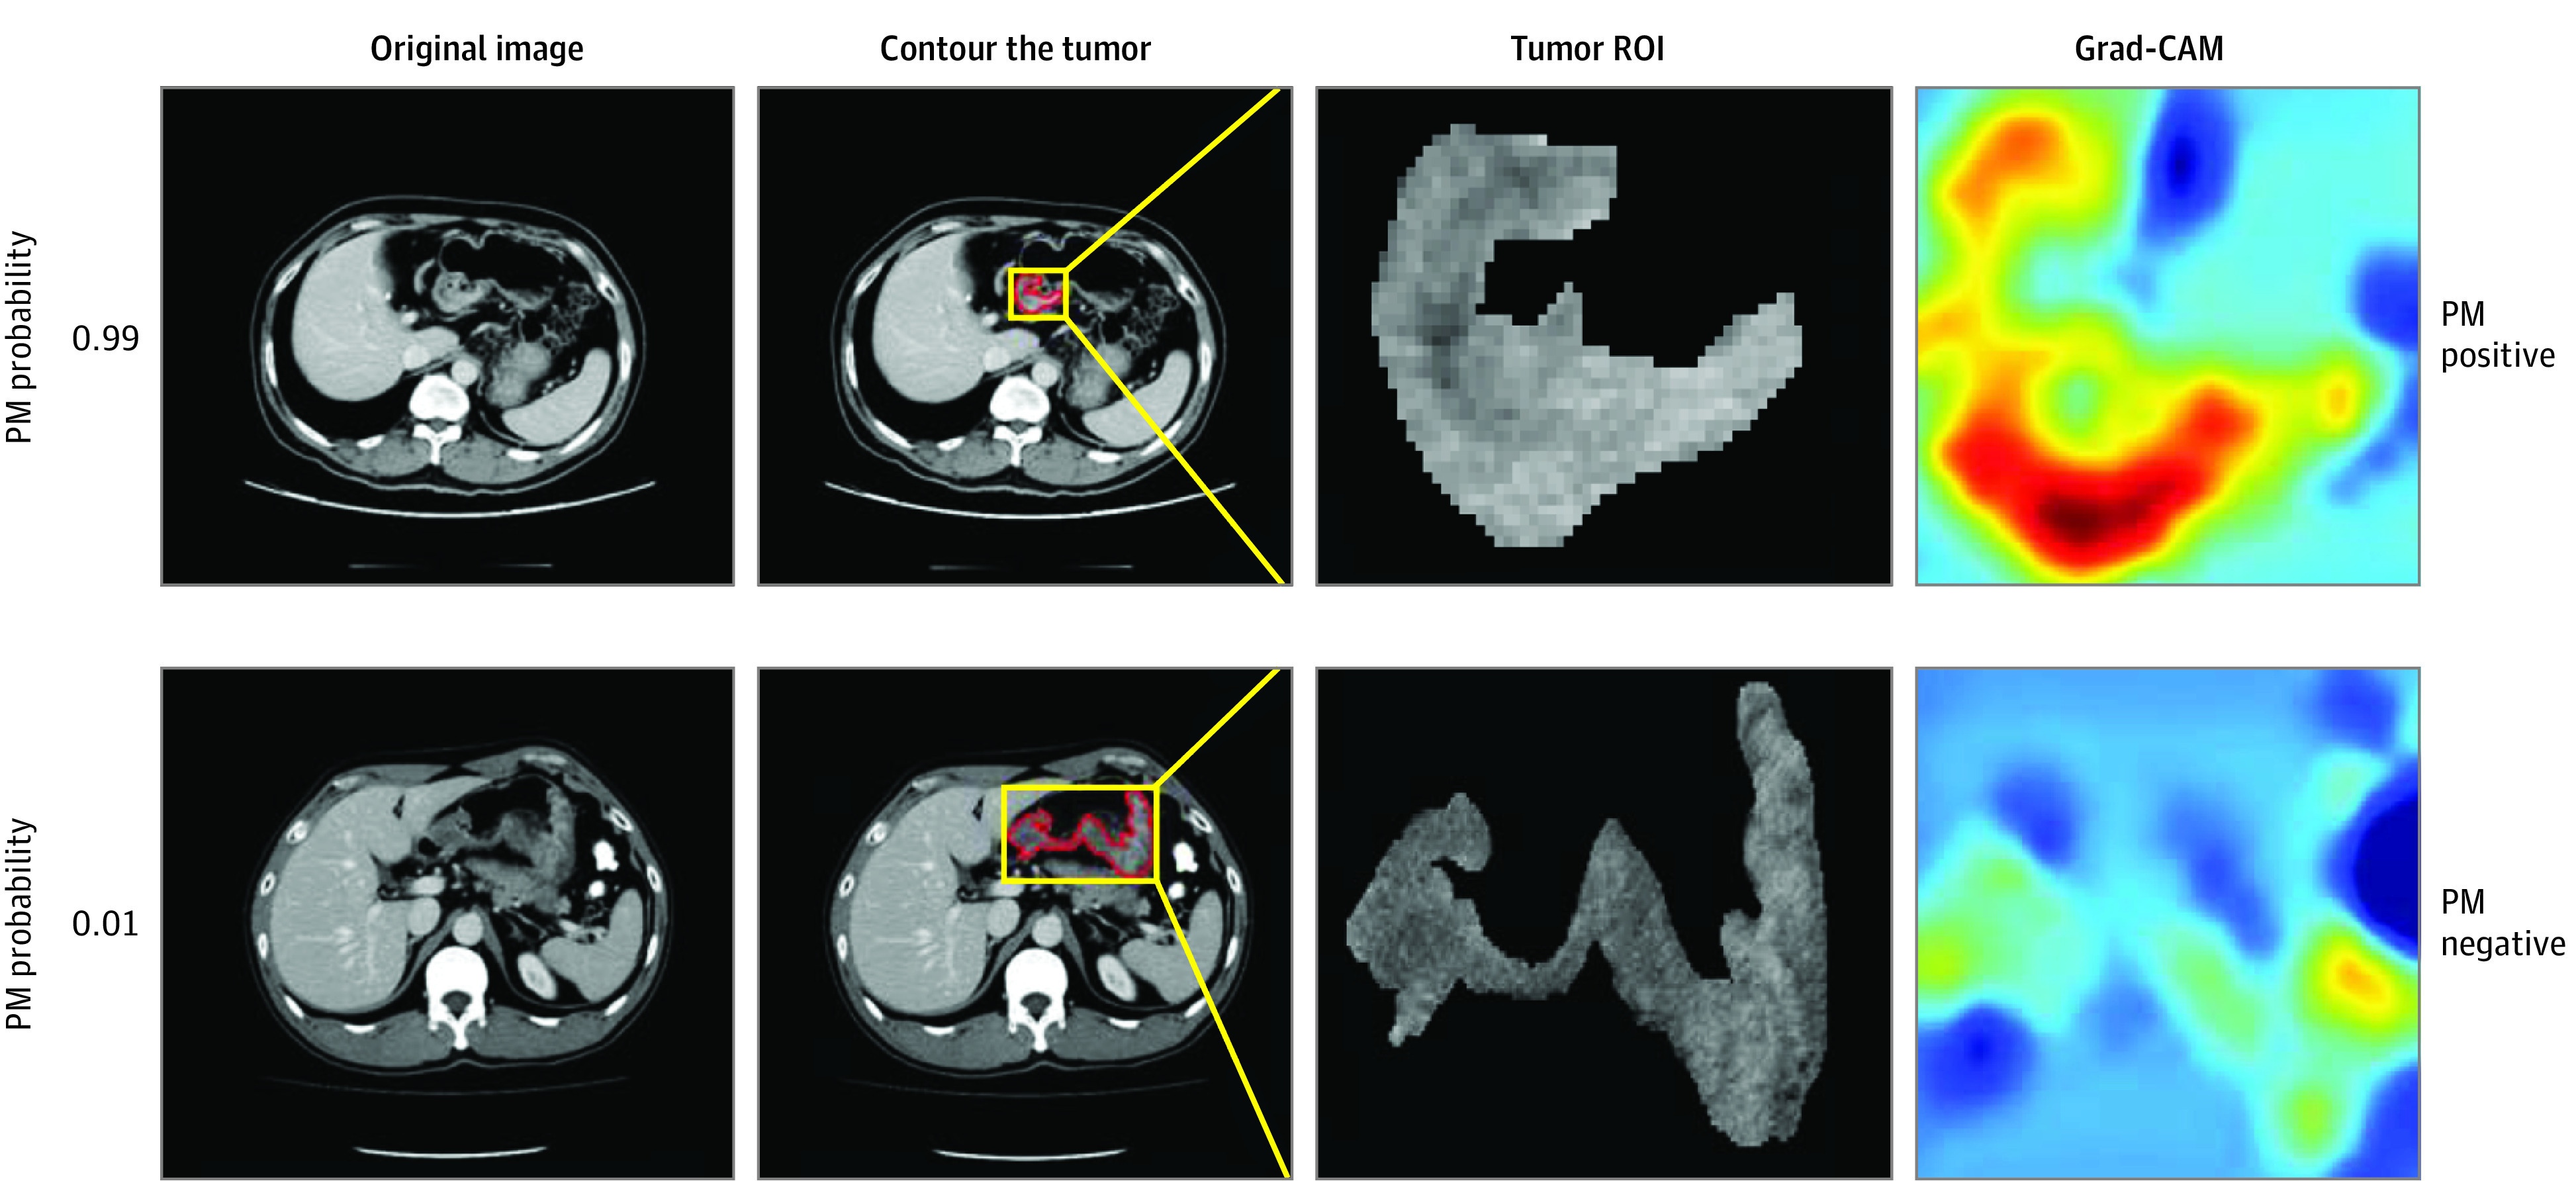
Two Representative Computed Tomography (CT) Images and the Corresponding Output From the Deep Learning ModelThe gradient-weighted class activation mapping (Grad-CAM) was used to highlight which areas of the CT image are important in generating a particular prediction. The numbers 0.99 and 0.01 represent the predicted probability of peritoneal metastasis (PM).ROI indicates region of interest.